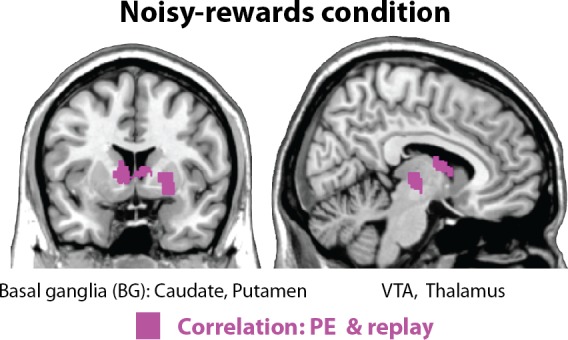
Correlation between the brain’s response to unsigned prediction errors and subsequent replay (purple), replanning behavior (blue), and their conjunction (green) in revaluation blocks, run separately for the noisy and noiseless conditions.Results are shown based on extent threshold p < 0.005 and cluster (family wise error) correction at p < 0.05. The only one of these analyses to yield any significant clusters was the correlation between PE and replay in the noisy condition (shown below), in which the magnitude of sensitivity to unsigned PE in the ventral tegmental area (VTA), the thalamus, and the basal ganglia (including the caudate and putamen) predicted subsequent replay during rest periods.